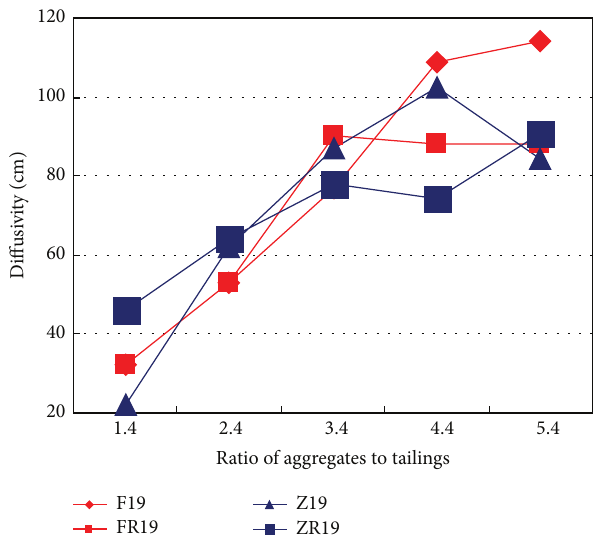
Figure 9: Backfill slurry diffusivity using 19% cement content.